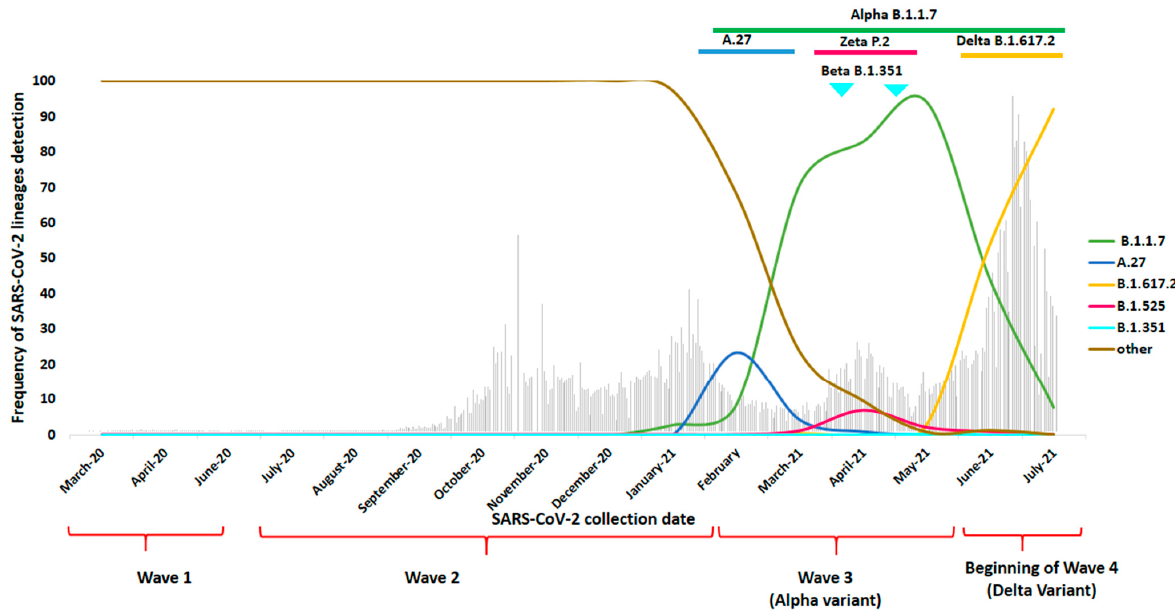
Figure 3. Emergence of variants of concern (VOCs) and variants of interest (VOIs) in Tunisia between March 2020 and July 2021. In the background, is the number of positive cases detected in Tunisia according to the statistics published in the World Health Organization (WHO) website [18].